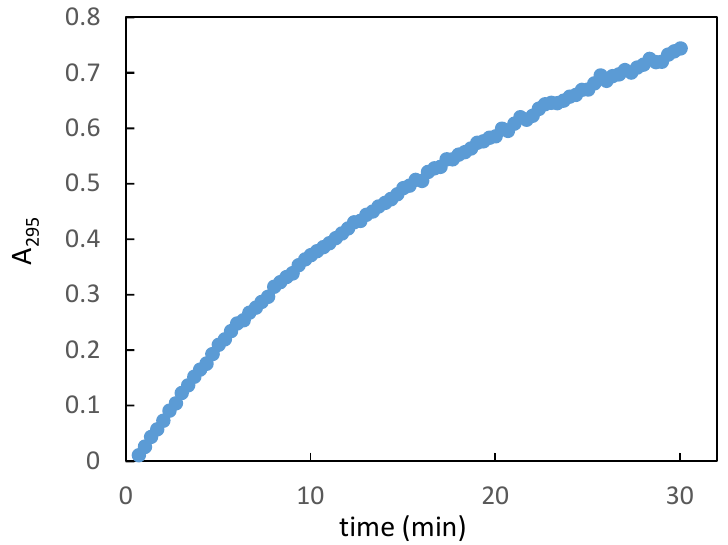
Figure 2. Increase in absorbance (295 nm) as a function of time; average of two experiments.